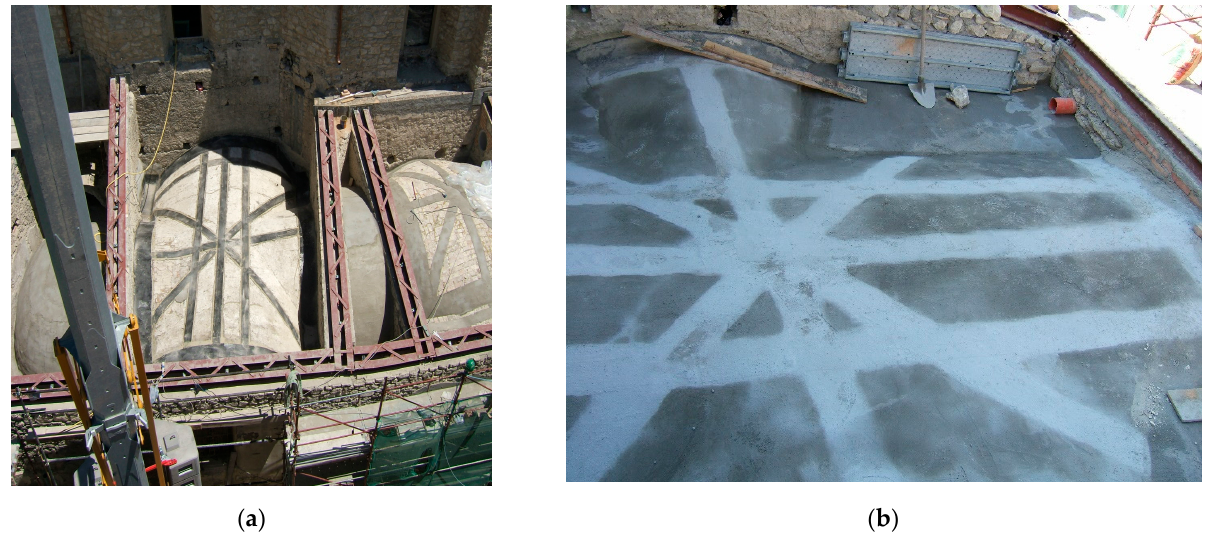
Figure 3. Composite strengthening of a cross vault: ( a ) detail of the composite reinforcement; ( b ) detail of the completed intervention.